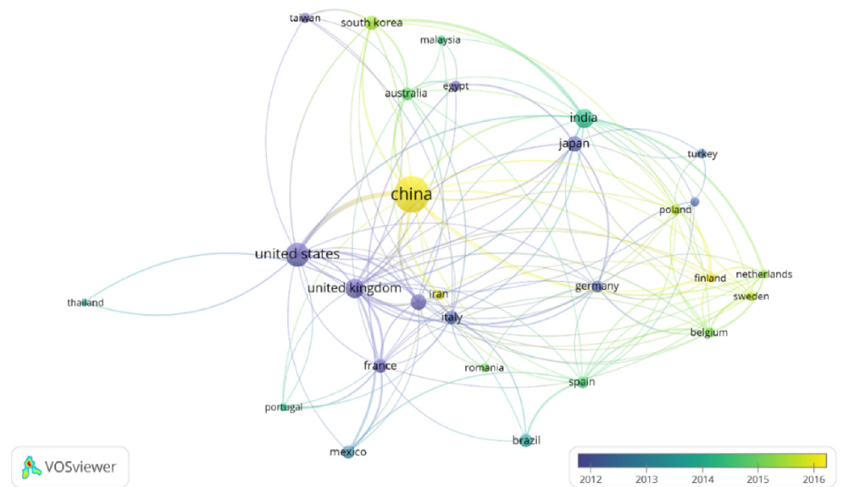
Figure 2. Publication density of countries by years including the term “electrodeposition” and “metal recovery”. Minimum number of publications by country: 13. Figure made with the software VOSviewer .